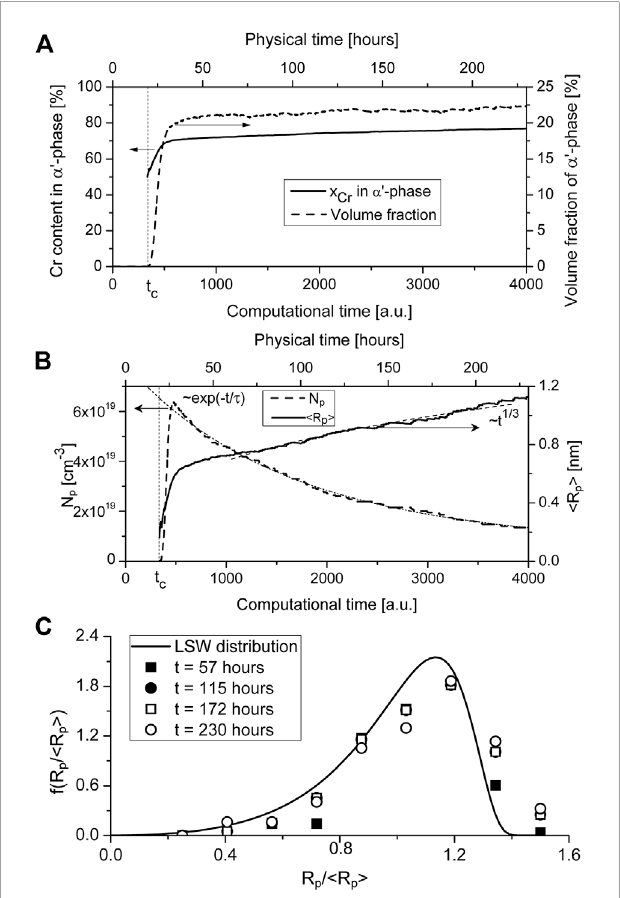
FIGURE 3 Evolution of (A) the Chromium concentration in the α ′ -phase and the volume fraction of the α ′ -phase precipitates and (B) the average size (radius) of the α ′ -phase precipitates and their number density; (C) distribution of α ′ -phase precipitates over size at different time instants during annealing of the solid solution Fe − 30 %Cr − 5 %Al at T = 710 K , solid line relates to LSW distribution.